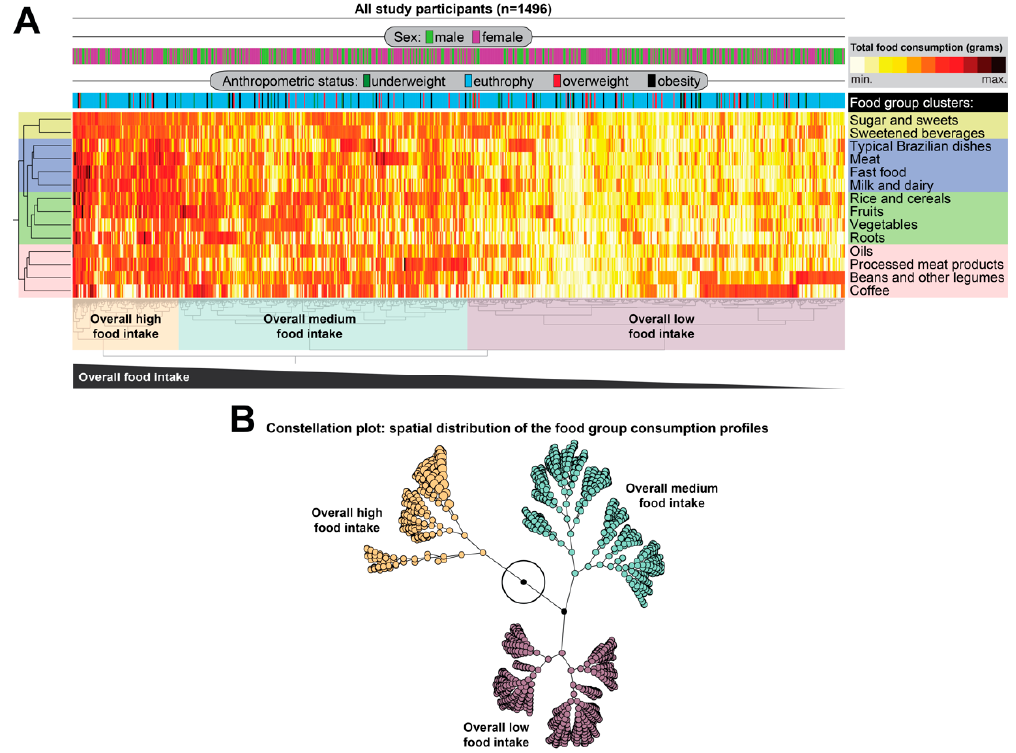
Figure 2. Analysis of the consumption of dietary groups using hierarchical cluster. The total consumption in grams obtained for each food group was calculated. ( A ) Two-way hierarchical cluster analysis (Ward’s method, unsupervised, with 100X bootstrap), in which the dendrogram represent Euclidean distance, was used as an approach to identify similarity profile of the consumption of distinct food groups. Using this approach, it was possible to identify four clusters of food groups that exhibited similar patterns of consumption in the general population. Three main subgroups of participants baes on overall food consumption was observed. ( B ) Constellation plot of the hierarchical clusters shows similarities between subgroups of study participants stratified by overall food intake.